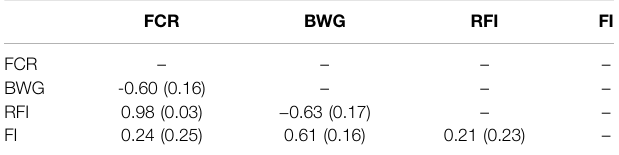
TABLE3| Estimatedgeneticcorrelation withstandarderrorinbracketsestimated using GBLUP models among feed conversion ratio (FCR), body weight gain (BWG), residual feed intake (RFI) and feed intake (FI). FCR BWG